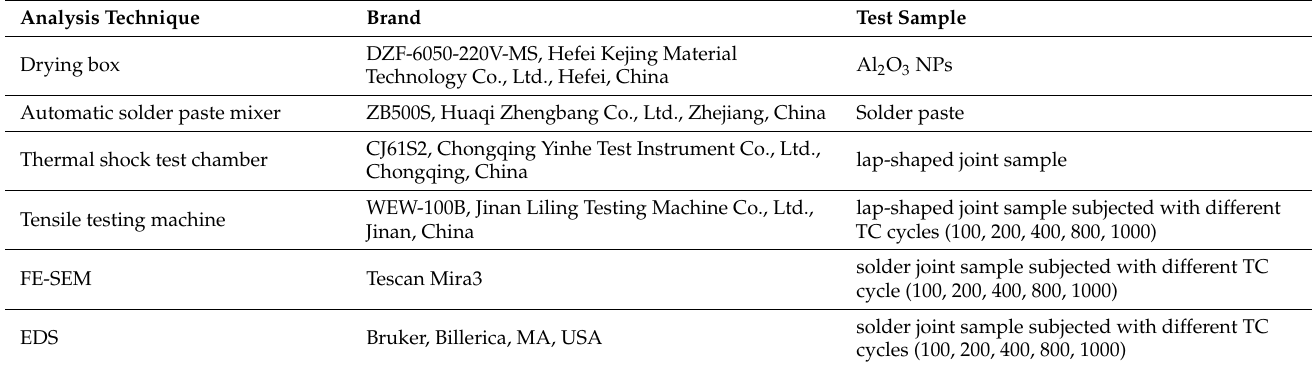
Figure 1. ( a ) SEM image of Al 2 O 3 nanoparticles; ( b ) Changes in shear strengths of SAC105/Cu and SAC105-(nano)Al 2 O 3 /Cu solder joints. Table 1. Samples with different analysis technique.